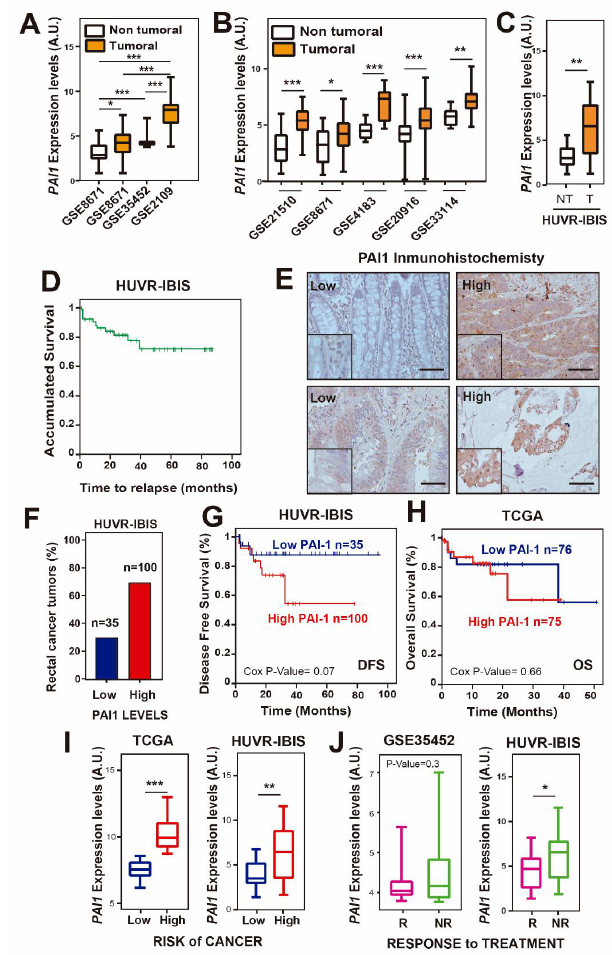
Figure 1. PAI1 expression is upregulated and reduces overall survival in rectal cancer patients. ( A ) PAI1 expression in the rectal cancer patient databases GSE35452, GSE8671 and GSE2109. ( B ) PAI1 expression in colorectal cancer patients from databases GSE21510, GSE8671, GSE4183, GSE20916 and GSE33114. ( C ) PAI1 expression in rectal patients from the HUVR-IBIS database. For ( A – C ), box plots show PAI1 expression levels in rectal tumor tissue (orange) or non-tumor tissue (white) patients. In ( A ), data were compared using the ANOVA test, except for the GSE35452, whose data were not normally distributed and thus a non-parametric Mann–Whitney’s t -test was used. In ( B , C ), tumoral and non-tumoral data were compared using Student’s t -tests. * p < 0.05; ** p < 0.01; *** p < 0.001. ( D ) Overall survival analysis of the HUVR-IBIS rectal tumor cohort (Table S1). ( E ) Representative images of PAI1 immunostaining in rectal cancer tissues. Scale bars, 50 µ m. The zoomed region has a magnification factor of 2. ( F ) Percentage of tumors with low or high PAI1 expression in our HUVR-IBIS cohort of rectal tumor samples ( n = 135). ( G ) Kaplan–Meier plot showing disease-free survival of patients with high (red) or low (blue) PAI1 expression levels in our own cohort from HUVR-IBIS. Data were analyzed with the log-rank test, and the associated P -values are shown in the graph. ( H ) Kaplan–Meier plot showing overall survival of patients with high (red) or low (blue) PAI1 expression levels in the TCGA rectal cancer patient database. P -values associated with the log-rank test are shown. ( I ) PAI1 expression levels by risk group in the TCGA rectal cancer patient database (left) and in the HUVR-IBIS cohort (right). ( J ) PAI1 expression levels in responder (R, pink) and non-responder (NR, green) to treatment patients in the GSE35452 database (left) and in the HUVR-IBIS cohort (right). For ( I , J ), data were compared using Student’s t -tests. * p < 0.05; ** p < 0.01; *** p < 0.001. For ( A – C , I , J ), box plots represent: center line, median; box limits, 25th and 75th percentiles; whiskers, minimum and maximum